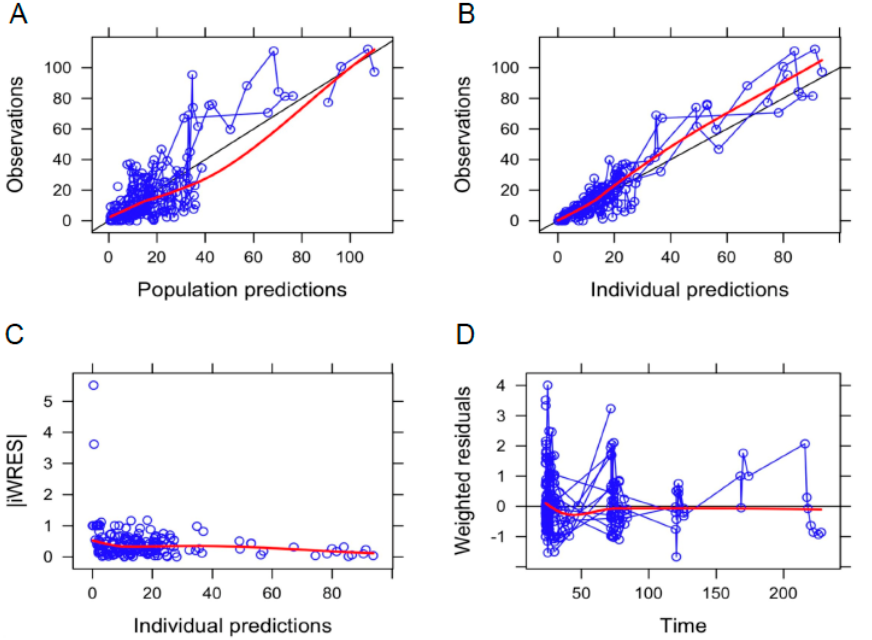
Figure 2. Goodness-of-fit plots for the final pharmacokinetic model. ( A ) Population and ( B ) individ- ual prediction values, ( C ) individual-weighted residuals (|IWRES|) vs. individual predictions, and ( D ) weighted residuals vs. time. Symbols, individual values; red line, LOWESS line.